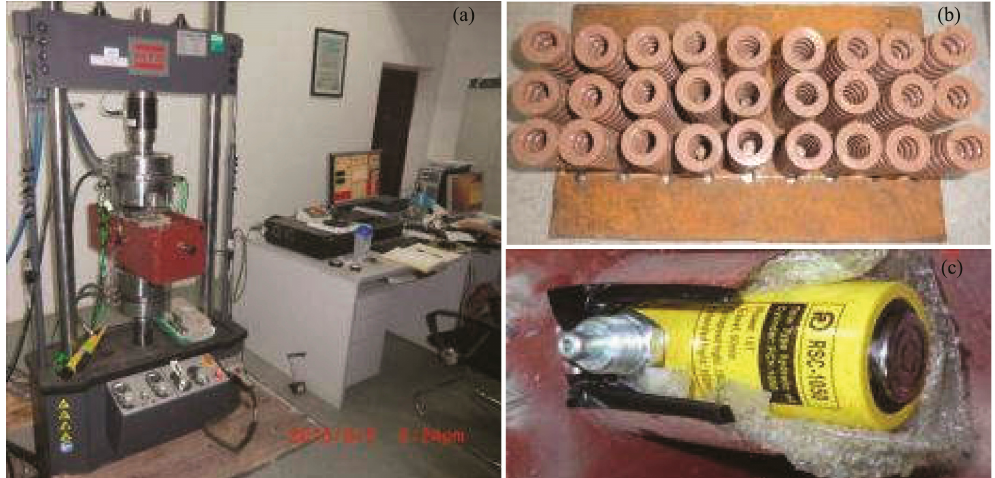
Figure 8. Test instrument and its components: ( a ) device box and MTS, ( b ) bottom spring plate, and ( c ) hydraulic jacks.